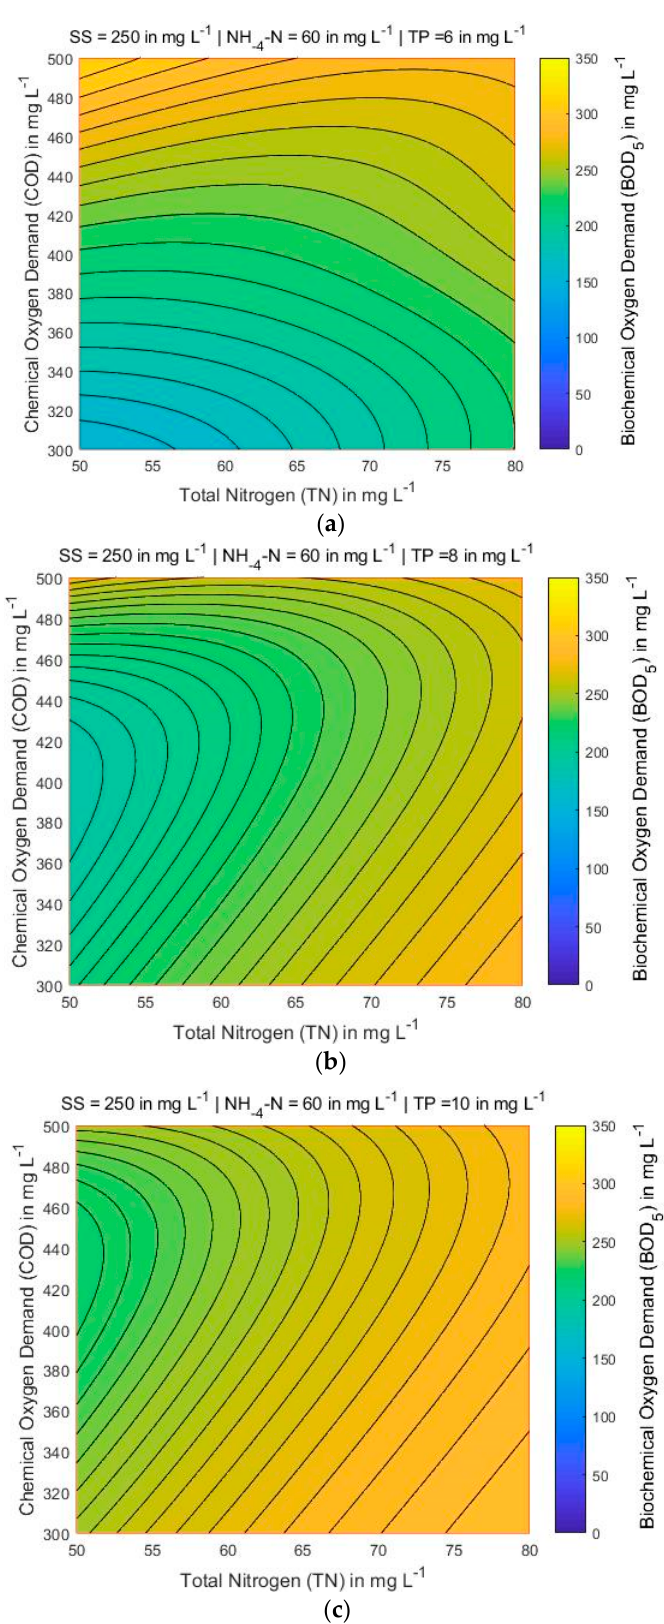
Figure 8. BOD 5 contour maps for three different values of NH 4 -N (in mg L − 1 ) while SS = 250 mg L − 1 and TP = 8 mg L − 1 are constant: ( a ) NH 4 -N = 50; ( b ) NH 4 -N = 60; and ( c ) NH 4 -N =70.